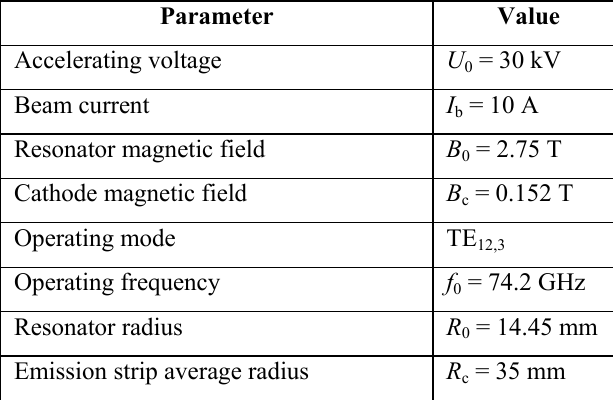
Table 1. Parameters of experimental